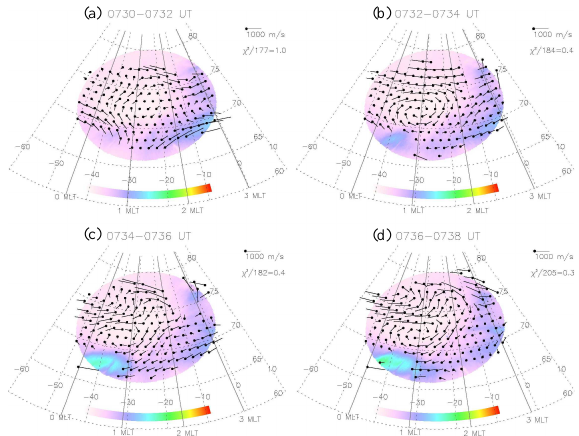
Figure 4 Maps showing the NASI 630.0 nm emissions and the SuperDARN convection velocities Fig. 4. Maps showing the NASI 630.0nm emissions and the Super- (arrows) obtained from the FIT procedure ( Ruohoniemi and Baker , 1998) during the intervals 0730-0738 DARN convection velocities (arrows) obtained from the FIT pro- UT. The radar data is for a standard 2-minute scan, while the 20-second NASI data is averaged over that cedure (Ruohoniemi and Baker, 1998) during the intervals 07:30– same 2-minute interval. The chi-squared value and the number of actual data points are labeled in the 07:38 UT. The radar data is for a standard 2-min scan, while the upper right corner of each frame. 20-s NASI data is averaged over that same 2-min interval. The chi- squared value and the number of actual data points are labeled in the upper right corner of each frame.